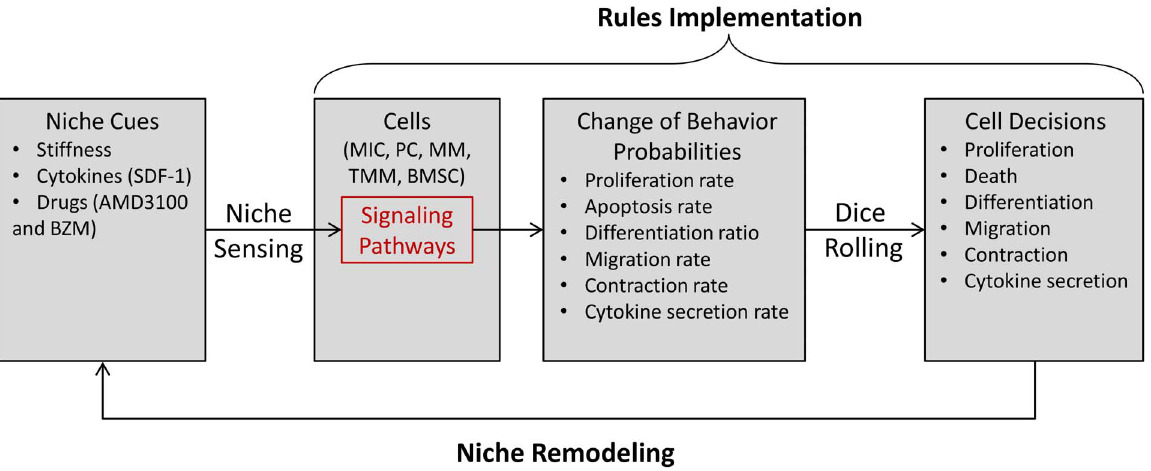
Figure 8. The stochastic simulation of cell behaviors using rule implementation, dice-rolling-based decision-making, and Markov chain Monte Carlo approaches.